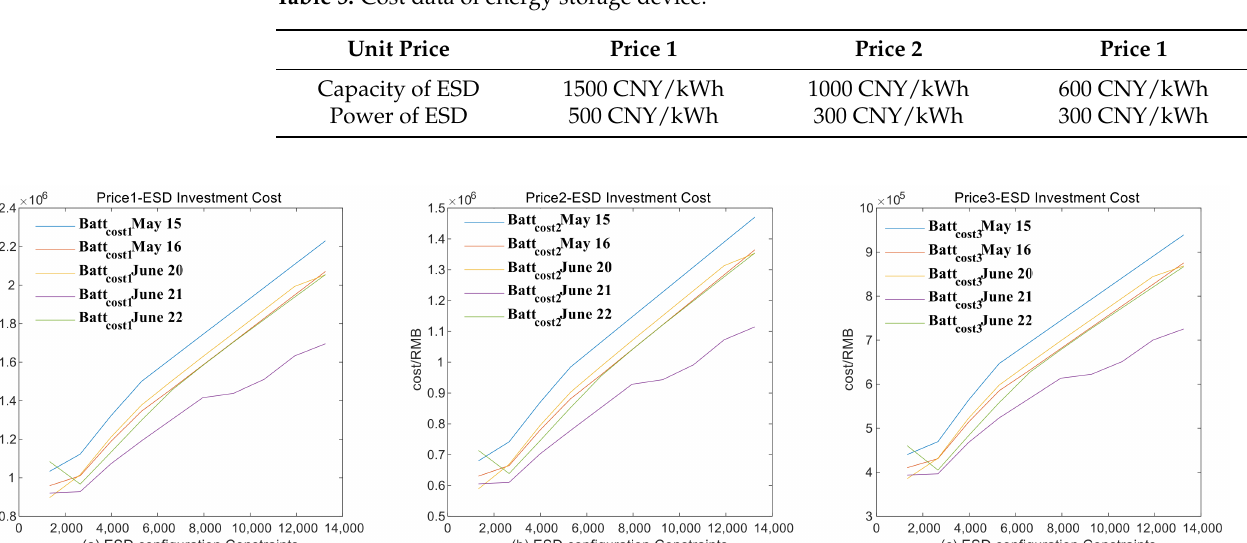
Table 5. Cost data of energy storage device.